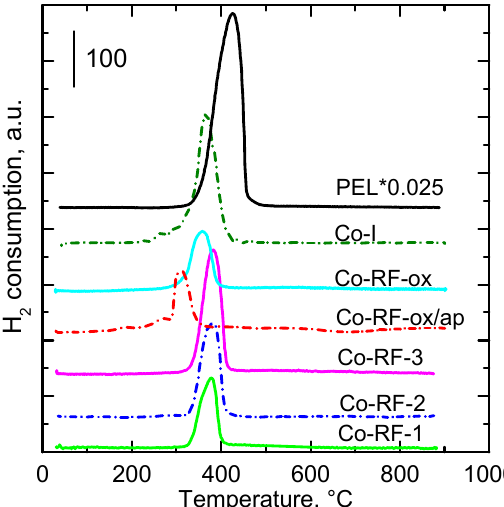
Figure 4. H 2 -TPR profiles of the supported cobalt oxide catalysts and pelletized commercial Co 3 O 4 catalyst (PEL).